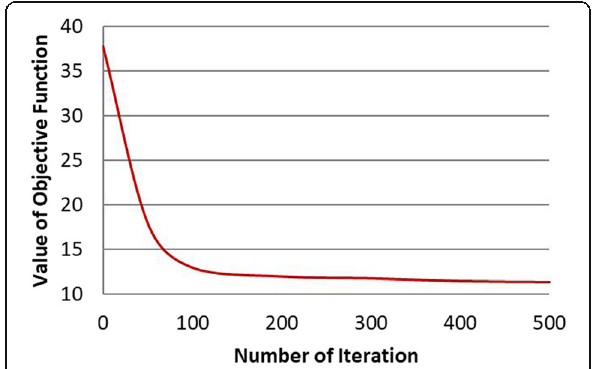
Fig. 3 Convergence of the objective function on FG-NET dataset